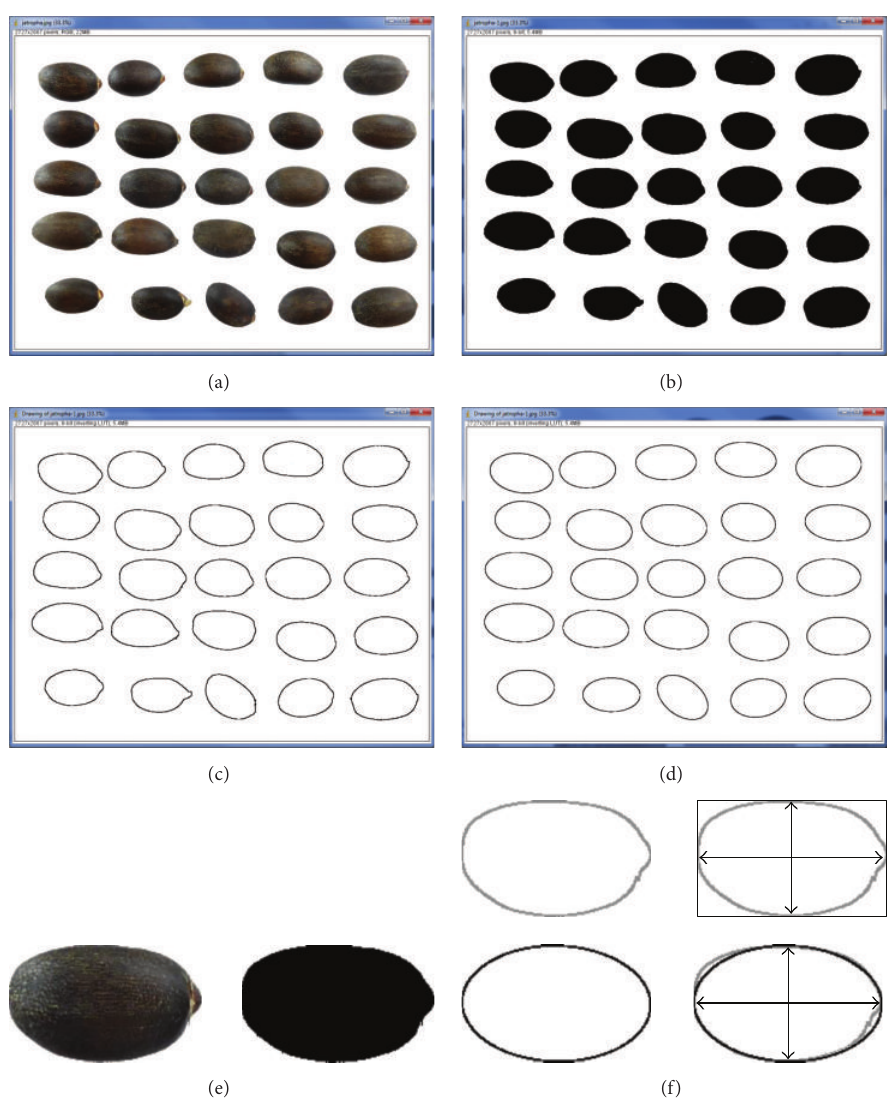
Figure 1: Digital processing of Jatropha curcas L. seed images. (a) Images corresponding to 25 seeds. (b) Binary images (black and white) of the seeds obtained by segmentation of the figure. (c) Silhouettes of seed images. (d) Ellipses adjusted to each seed image (fitted ellipses are given by the program Image J). (e) A seed with its image after segmentation and the silhouettes of the image (top) and the adjusted ellipse. (f) An example of the seed with its bounding rectangle (top) and the seed with the fitted ellipse, showing in both cases the major and minor axes. The values of area and perimeter, length, and width are obtained directly with Image J. The values are used to obtain the shape descriptors. The comparison of the area of the seed with the area of a model ellipse is used in the calculation of J index. J index is the ratio of shared (area common between seed and ellipse)/unshared area (see the text and Figure